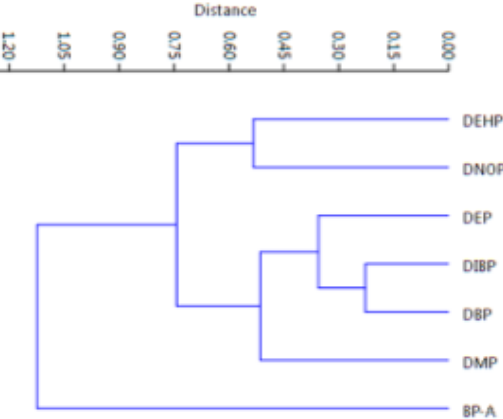
Figure 6. Hierarchical Cluster Analysis for evidencing the correlations among the six PAEs and the BP-A.